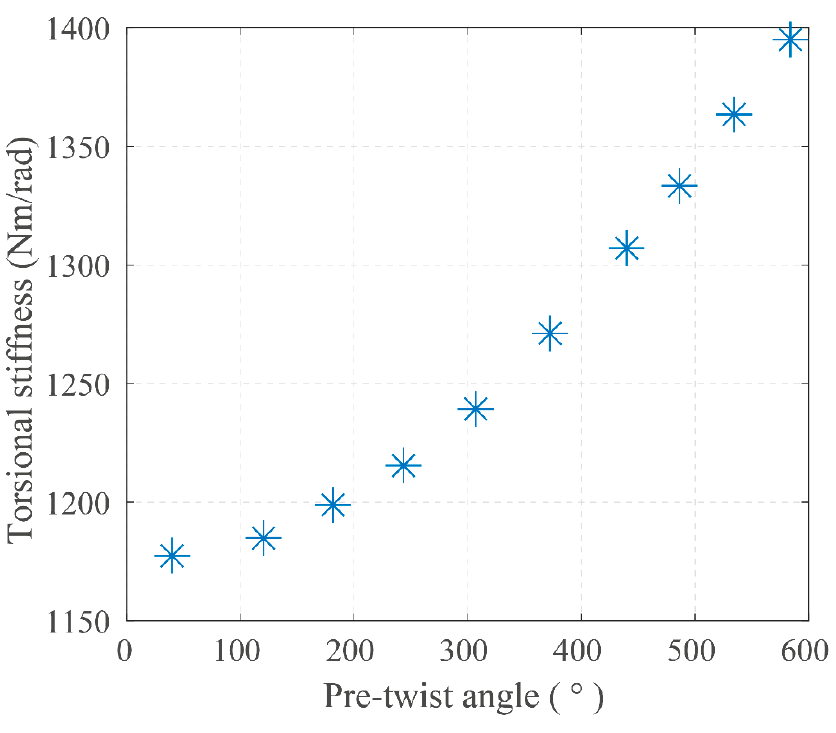
Figure 6. Torsional stiffness versus total pre-twist angle for the solid drill, according to the 3D FEM model.